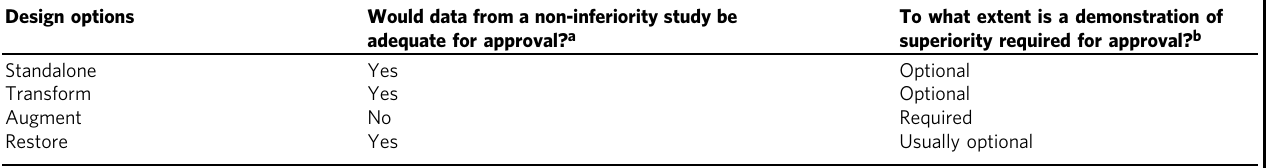
Table 3 Development options for the four categories Design